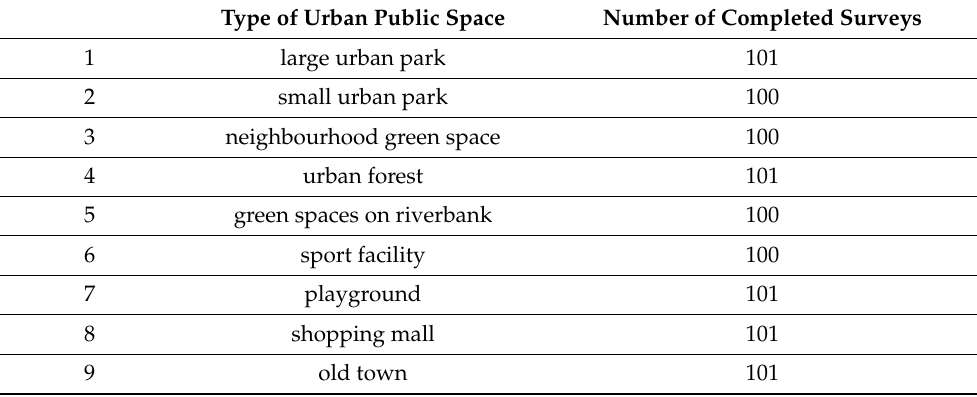
Table 1. Typology of urban public spaces and numbers of completed surveys per public